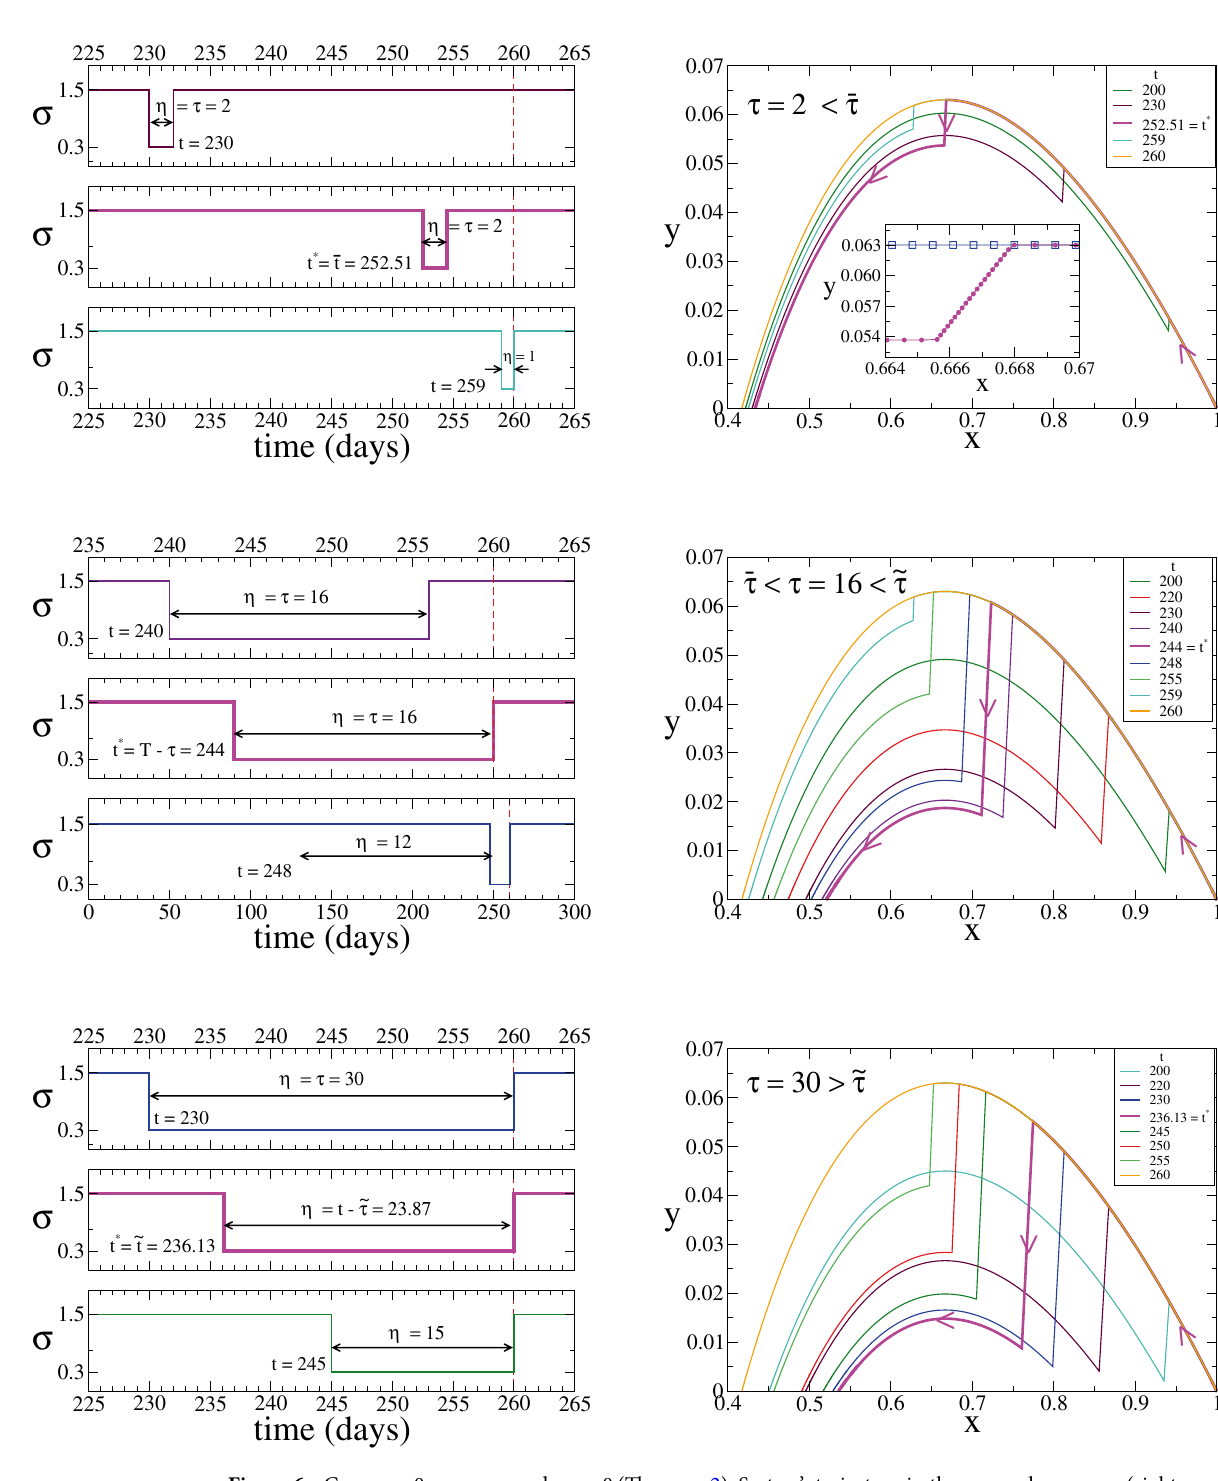
Figure 6. Case κ = 0 , σ m = σ f and σ s > 0 (Theorem 2). System’s trajectory in the x − y phase space (right panels), for γ = 0.1 , κ = 0 , σ m = σ f = 1.5 , σ s = 0.3 and T = 260 , and the three values of τ indicated in the legends corresponding to the different regimes of the optimum time t ∗ (pink lines). Left panels show the time evolution of σ for three different initial times t of the strict quarantine in each case. The optimum times are t ∗ = t ≃ 252.51 for τ = 2 (top panels), t ∗ = T − τ = 244 for τ = 16 (middle panels) and t ∗ = ˜ t ≃ 236.13 for τ = 30 (bottom